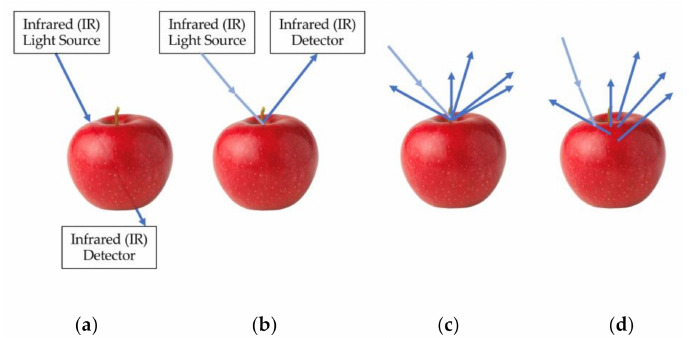
Figure 4. NIR Spectroscopy Configurations [59]. ( a ) transmittance; ( b ) reflectance; ( c ) diffuse reflectance; and ( d )